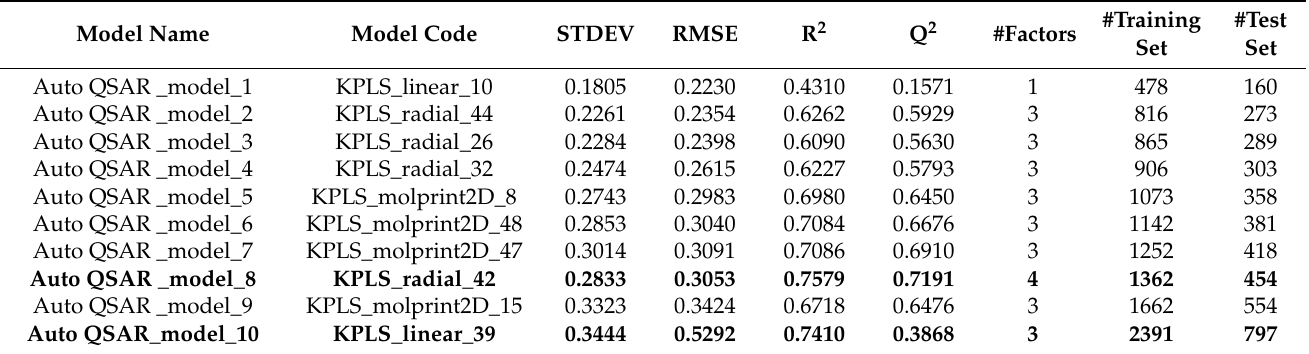
Table 1. The most optimum models generated by Auto QSAR to train the enumerated design ideas to predict their docking scores, following an active learning approach to assess their ability to bind to SARS-CoV-2 PL pro